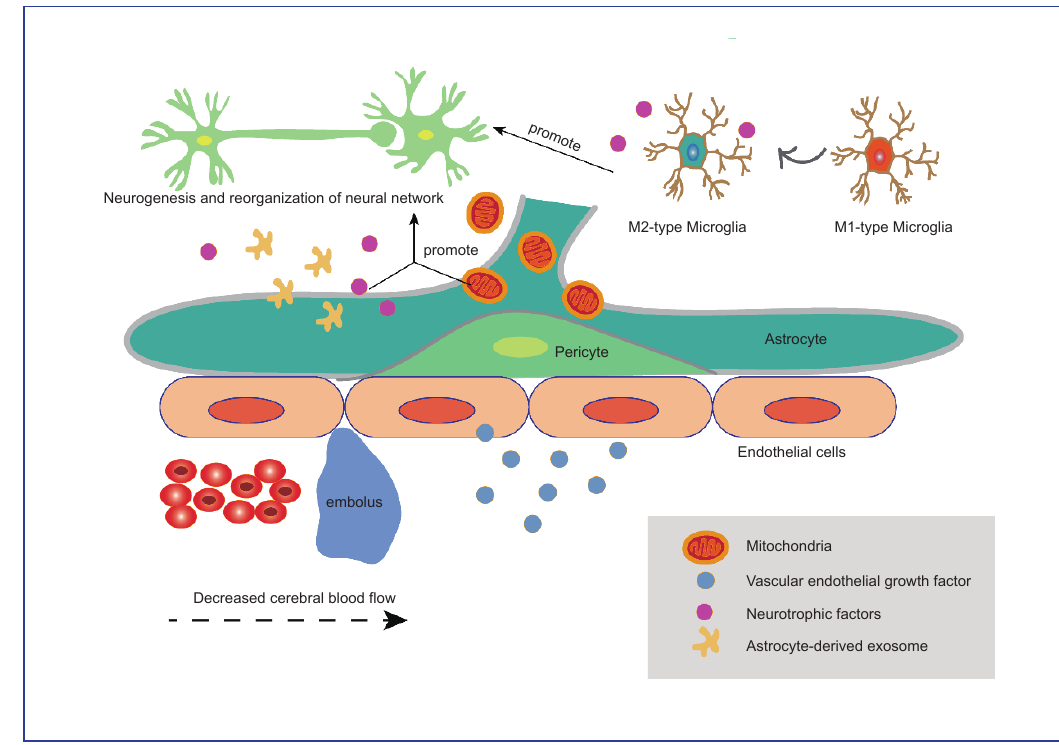
Figure 2 Repair mechanisms of neurovascular unit components in the stroke recovery period. The changes involved in this process include the transformation of microglia from a pro-inflammatory to an anti-inflammatory phenotype, and the secretion by astrocytes of neurotrophic factors and exosomes. Endothelial cells are also involved through the secretion of vascular endothelial growth